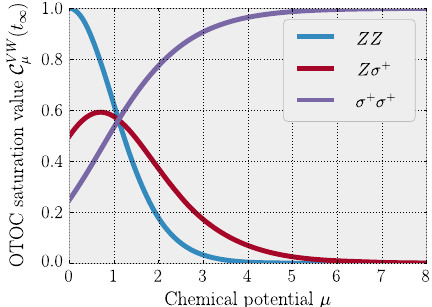
FIG. 10. Long-time saturation values of different OTOCs C WV , predicted by Eq. (25), as a function of the chemical potential μ